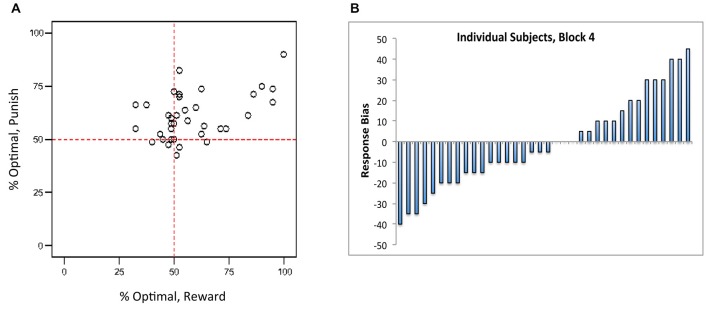
(A) Individual subjects showed considerable individual variation in reward-based and punishment-based learning, plotted here in terms of percent optimal responding on each trial type. (B) Near the end of the experiment (block 4), individual subjects showed a “bias” (difference between performance on reward-based vs. punishment-based trials) that varied from strongly negative (better performance on punishment-based trials) to strongly positive (better performance on reward-based trials). Each bar represents an individual subject, ordered along the x-axis by bias.